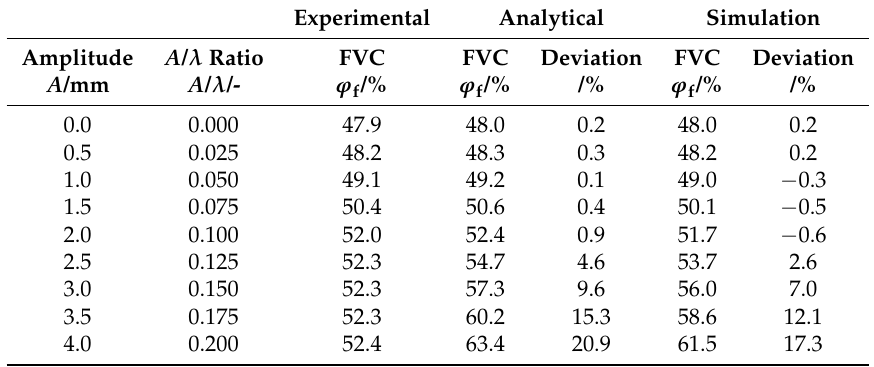
Figure 11. Computer tomography scan of a preform with waves (target values A / λ = 0.075,0.125 and 0.175) ( left ) and gaps with w gap = 2.5mm ( right ). Table 2. Comparison of fiber volume content results for wavy preforms with a wave length λ = 20mm, number of plies n L = 6 and an assumed laminate thickness of t = 2.24mm.